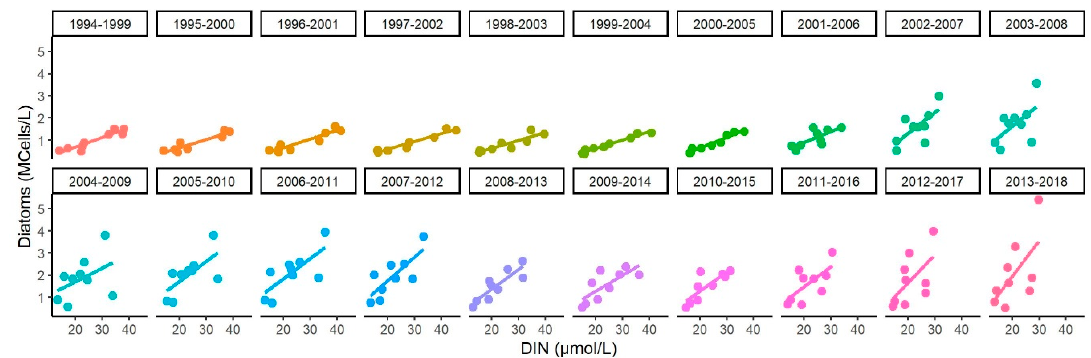
Figure A3. Linear regressions of the relationship between Phaeocystis and Dissolved Inorganic Nitrogen (DIN) concentrations by period. Input values for both variables are averaged maxima by period, calculated during the growing season for Phaeocystis and during the winter season for DIN.